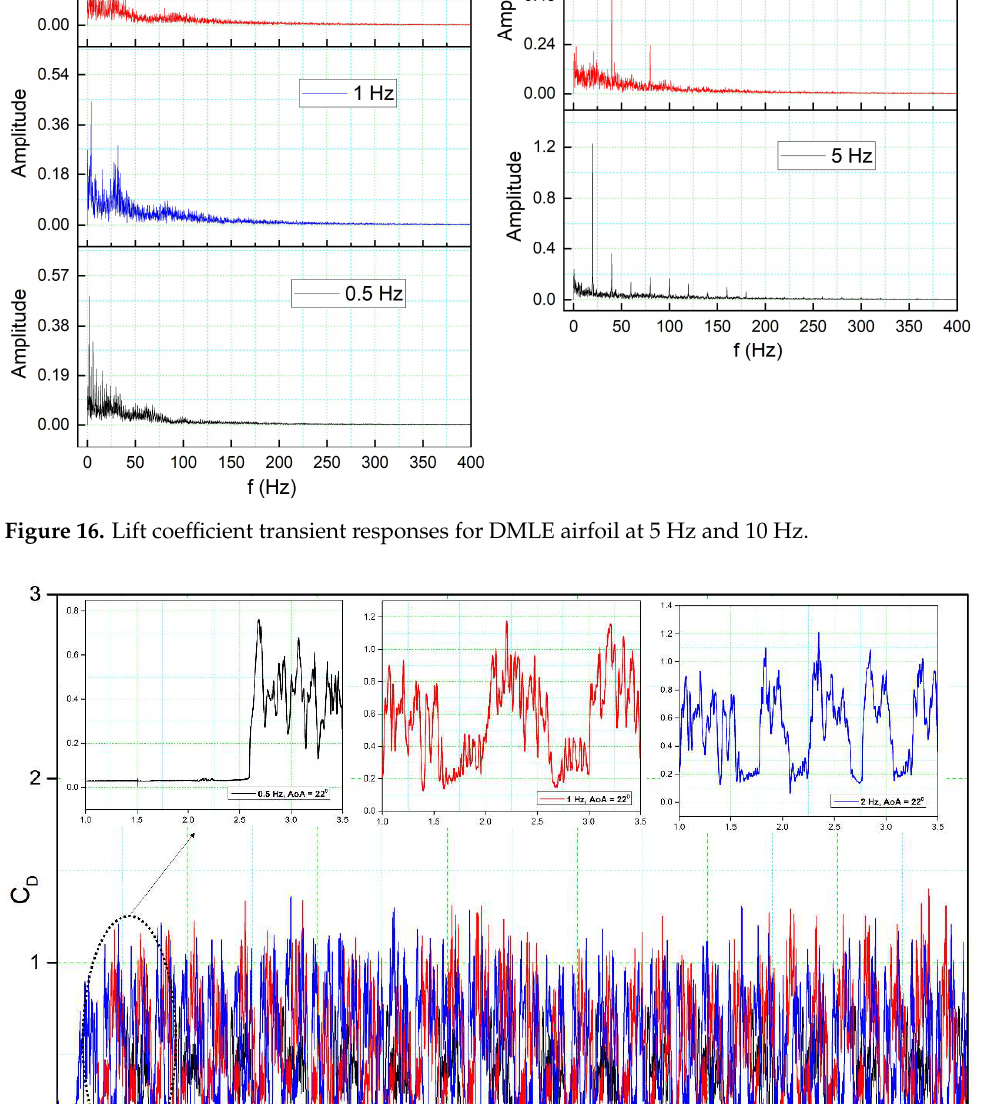
Figure 16. Lift coefficient transient responses for DMLE airfoil at 5 Hz and 10 Hz.